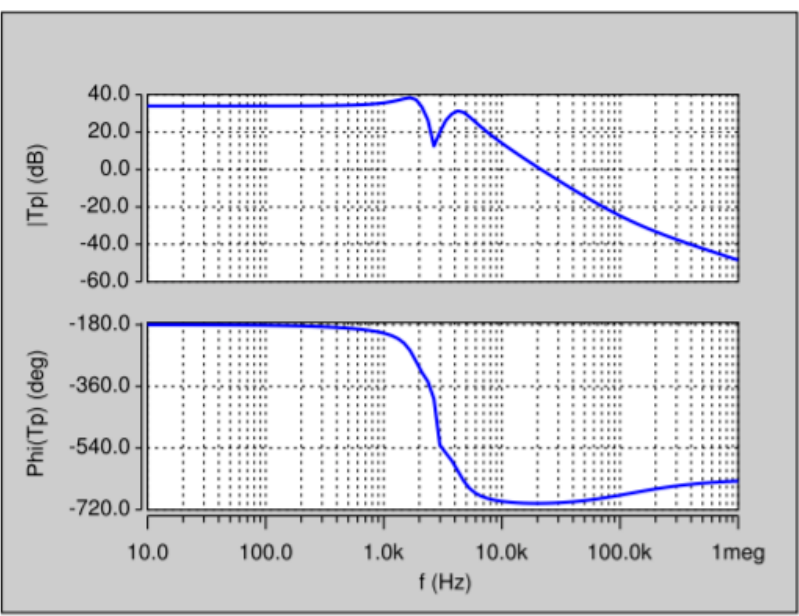
Figure 20. Theoretically derived G vd for a non-ideal Cuk converter [4].